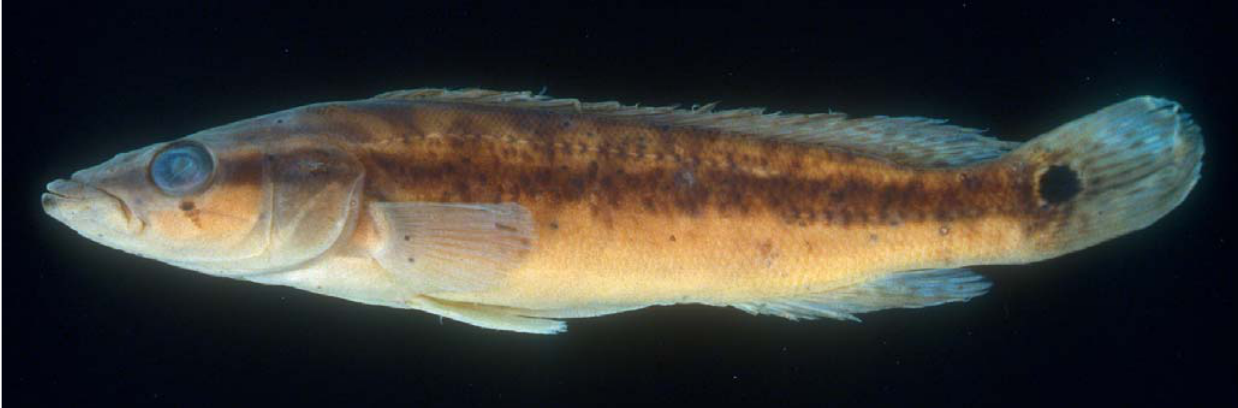
Fig. 7. Crenicichla tingui , female, MCP 12606, holotype, 98.0 mm SL, municipal border Paranaguá-Morretes, rio Jacarei, State of Paraná,